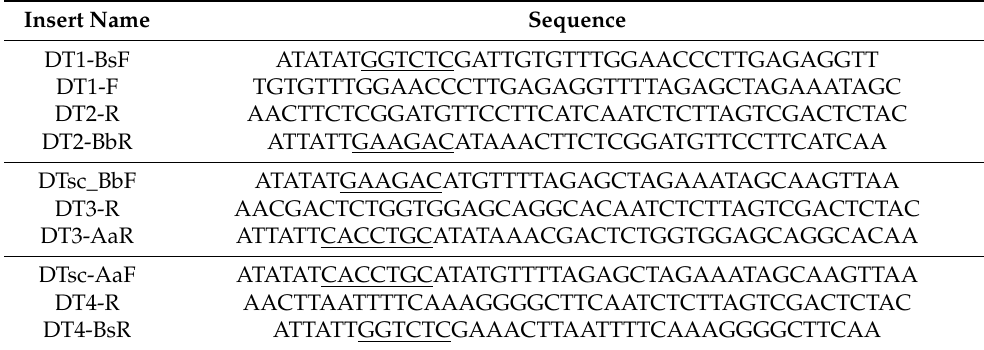
Table 15. List of primers and sequences for the pHEE401E_4sg